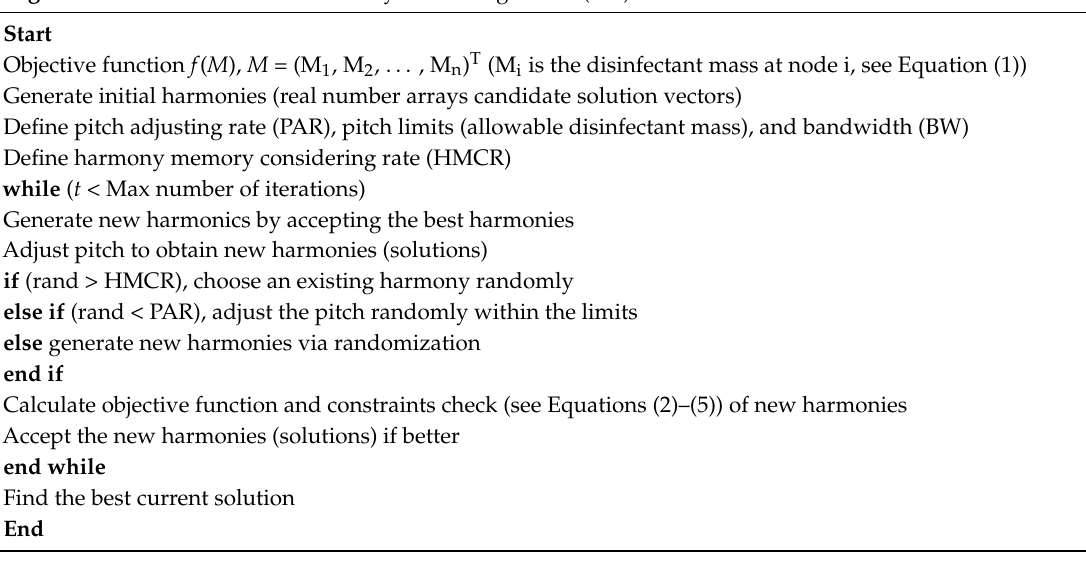
Algorithm 1 Pseudo-code for Harmony Search Algorithm